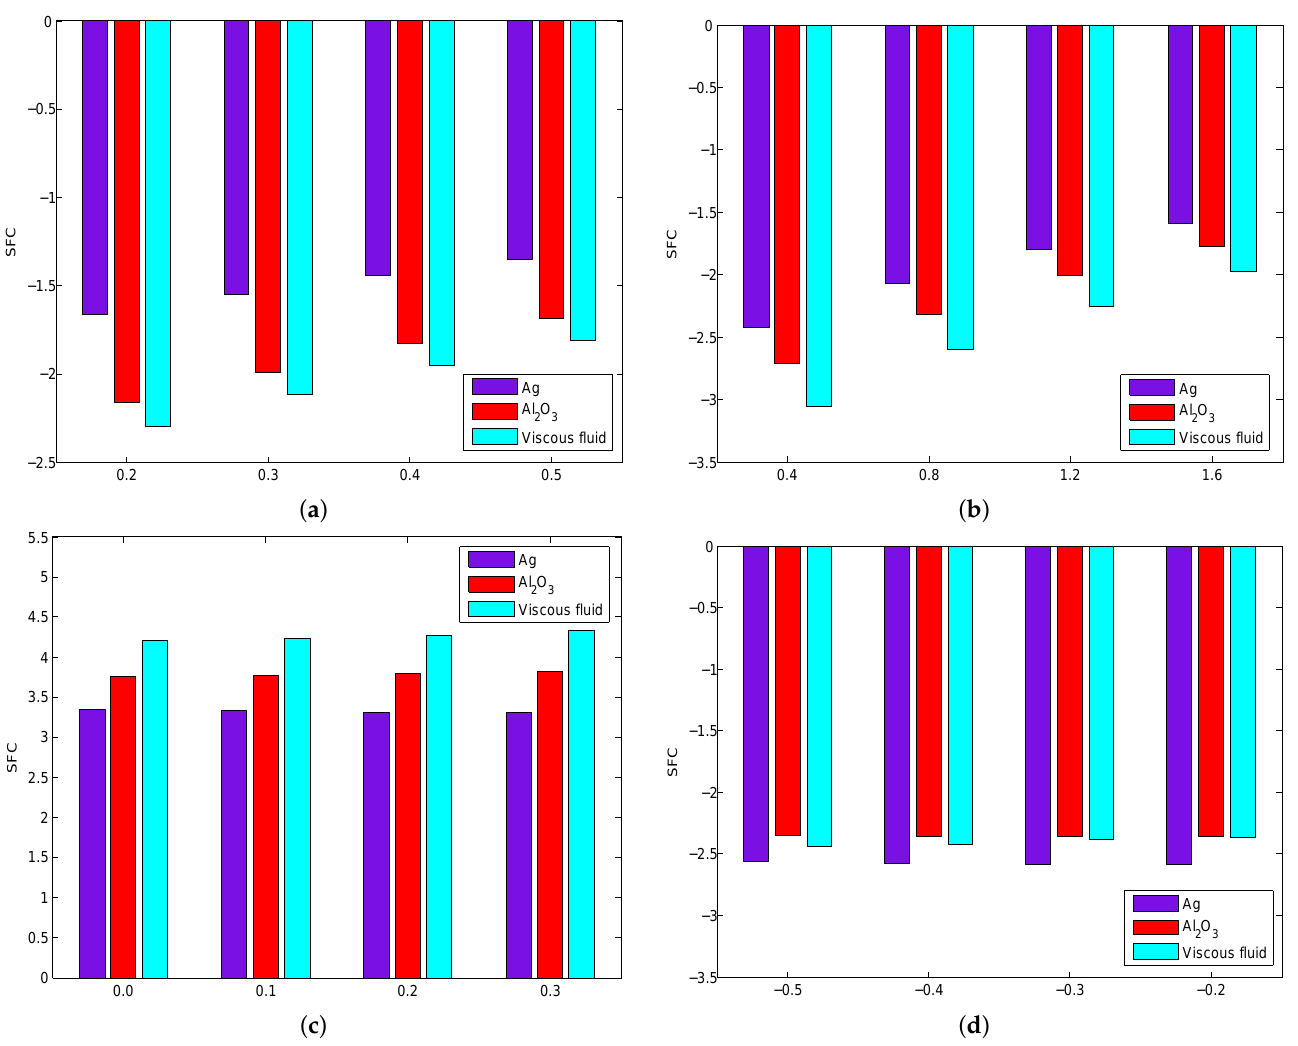
Figure 10. The increasing/declining percentage of SFC on ( a ) λ , ( b ) Fr , ( c ) Ha and ( d ) fw .